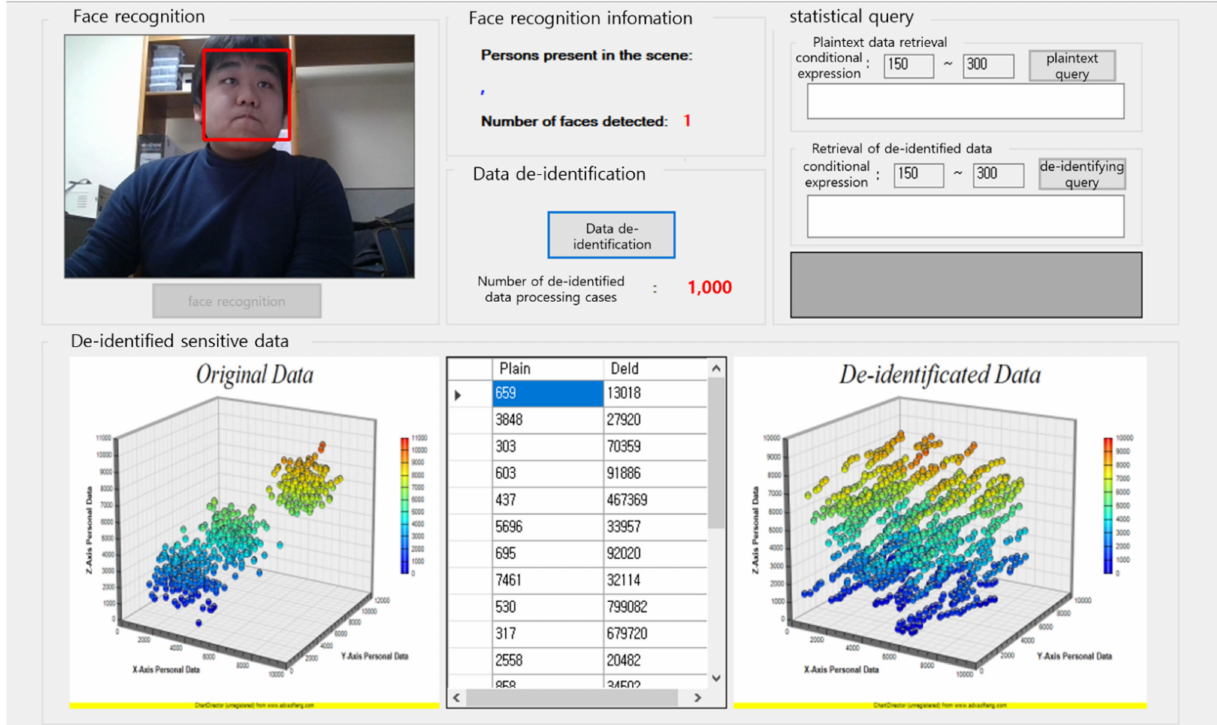
Figure 9. Three-dimensional graph of de-identification of facial